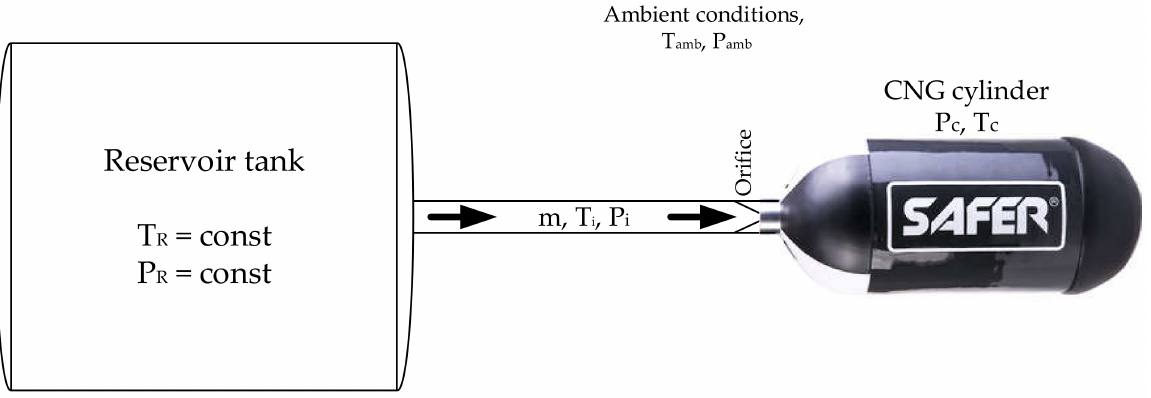
Figure 3. Thermodynamic scheme of the investigated system (buffer